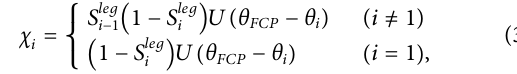
Frontiers in Robotics and AI |